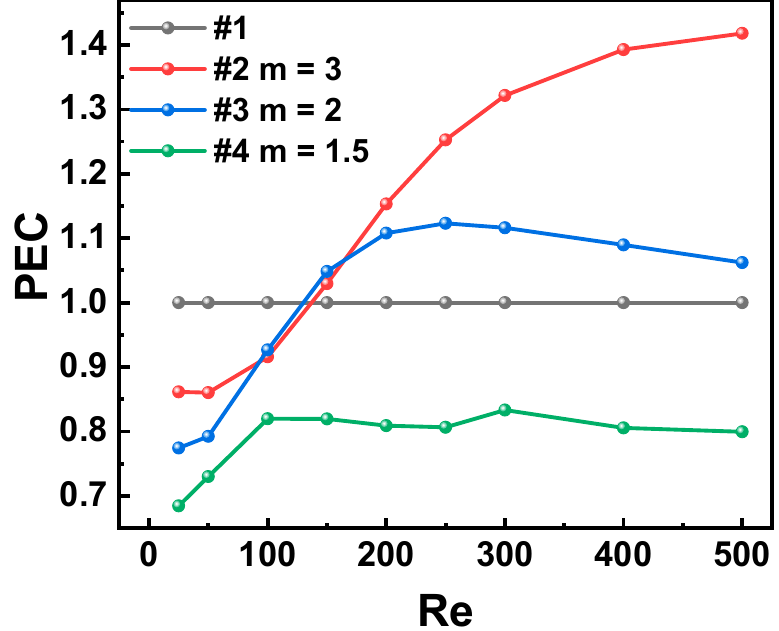
Figure 5. PEC versus Re with different fin aspect ratios.